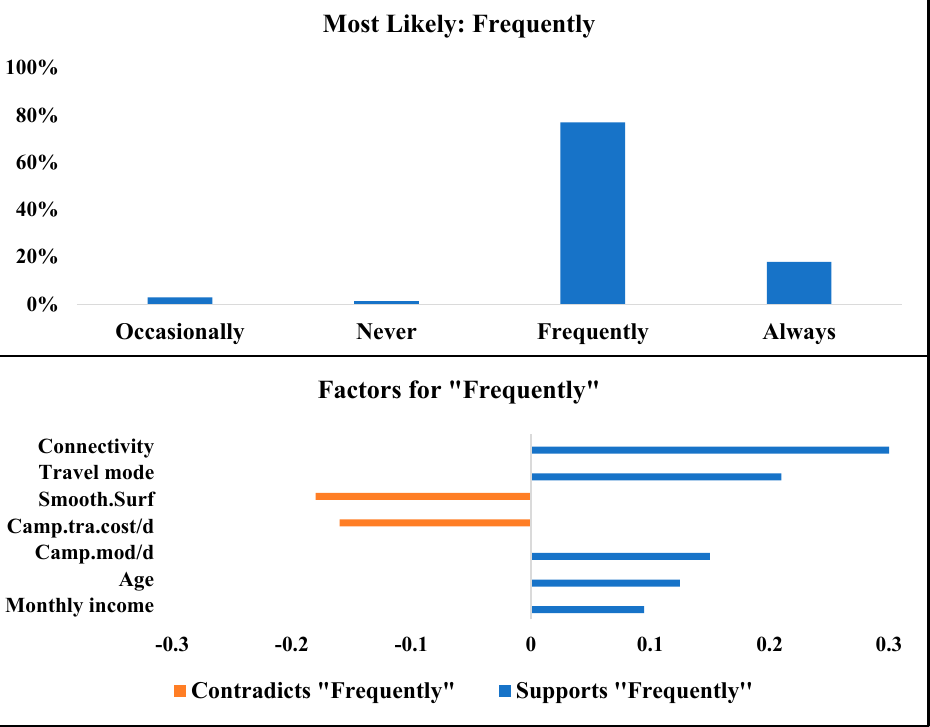
Figure 16. Optimization results and importance of variables based on the second scenario: Frequently use